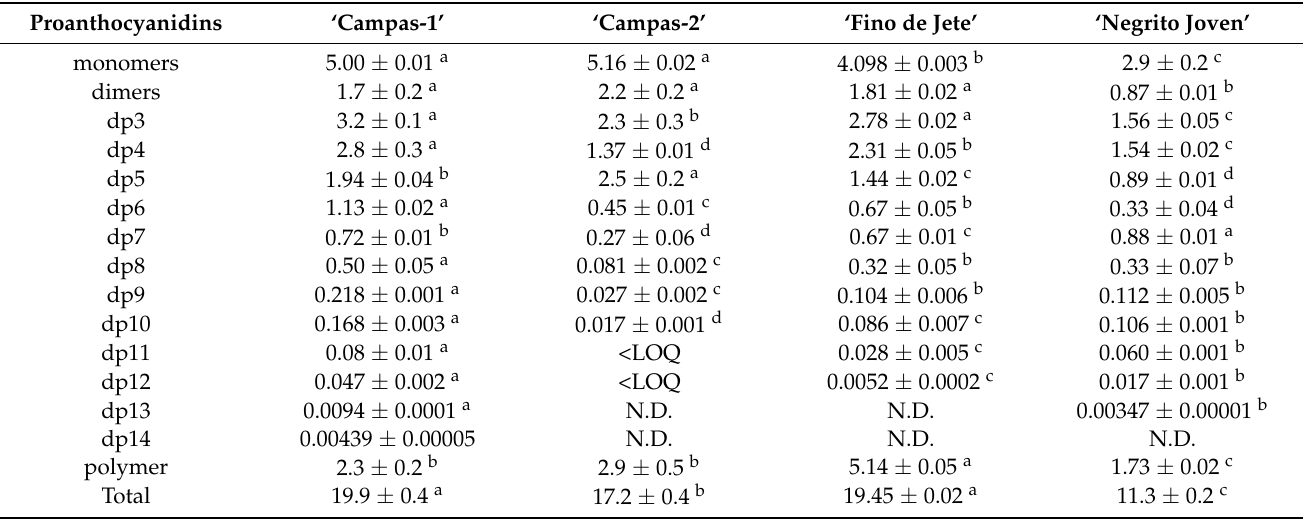
Table 7. Table of quantification of proanthocyanidins (mg/g d.w.) in different cultivars of cherimoya leaves at optimum sonotrode conditions by